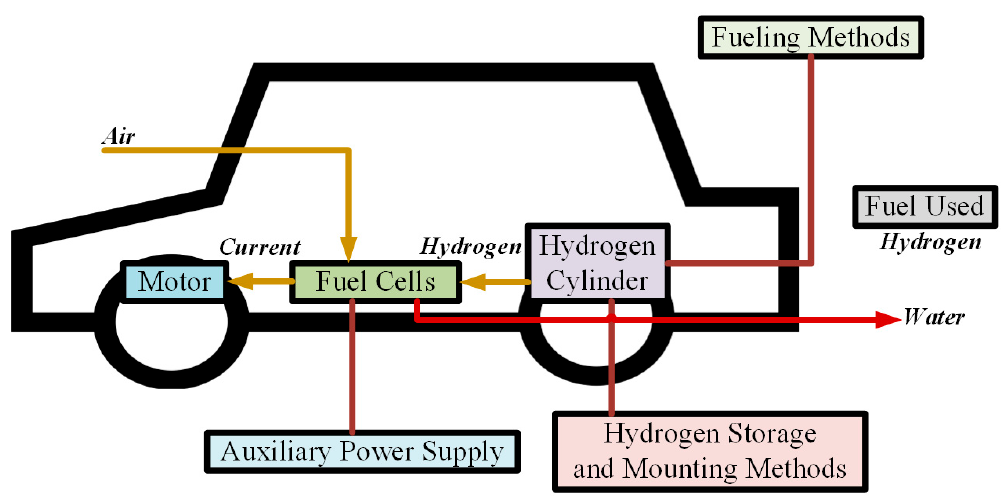
Figure 6. FCEV configuration. Oxygen from air and hydrogen from the cylinders react in fuel cells to produce electricity that runs the motor. Only water is produced as by-product which is released in the environment.